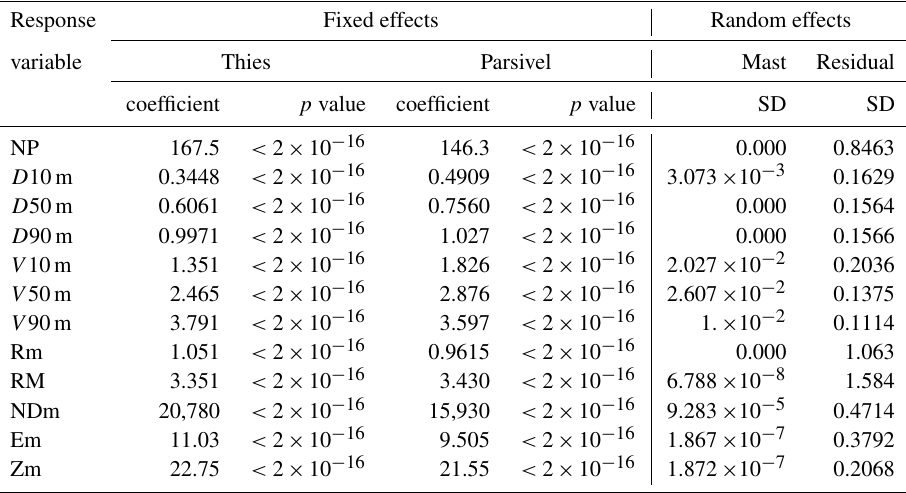
Figure 8. Violin plots for event means and maxima. Refer to Table 2 for a list of acronyms of the variables. Table 5. Gamma generalized linear mixed-effects models coefficients for event totals (sample size N = 624). Refer to Table 2 for a list of variable